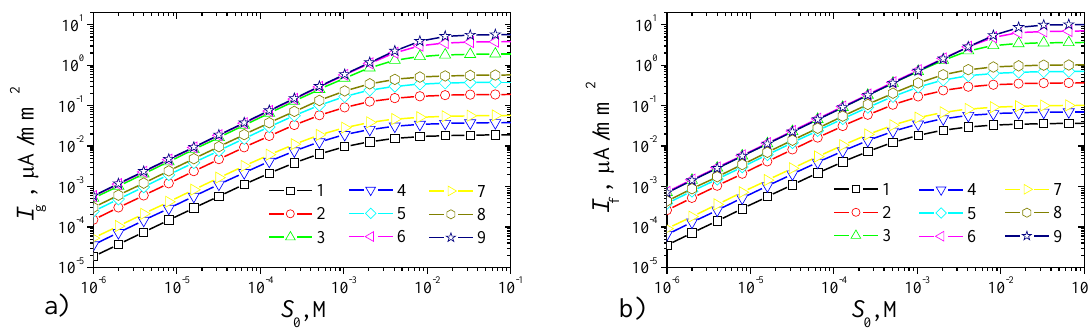
in the cases of plate − gap (a) and 0 : 0.1 (1, 4, 7), 1 (2, 5, 8), 10 (3, 6. 9) mM/s max = 0.1 µ m2/s, b = 2 a = 4 µ m, c = 4 µ m, δ = 2 µ m. m